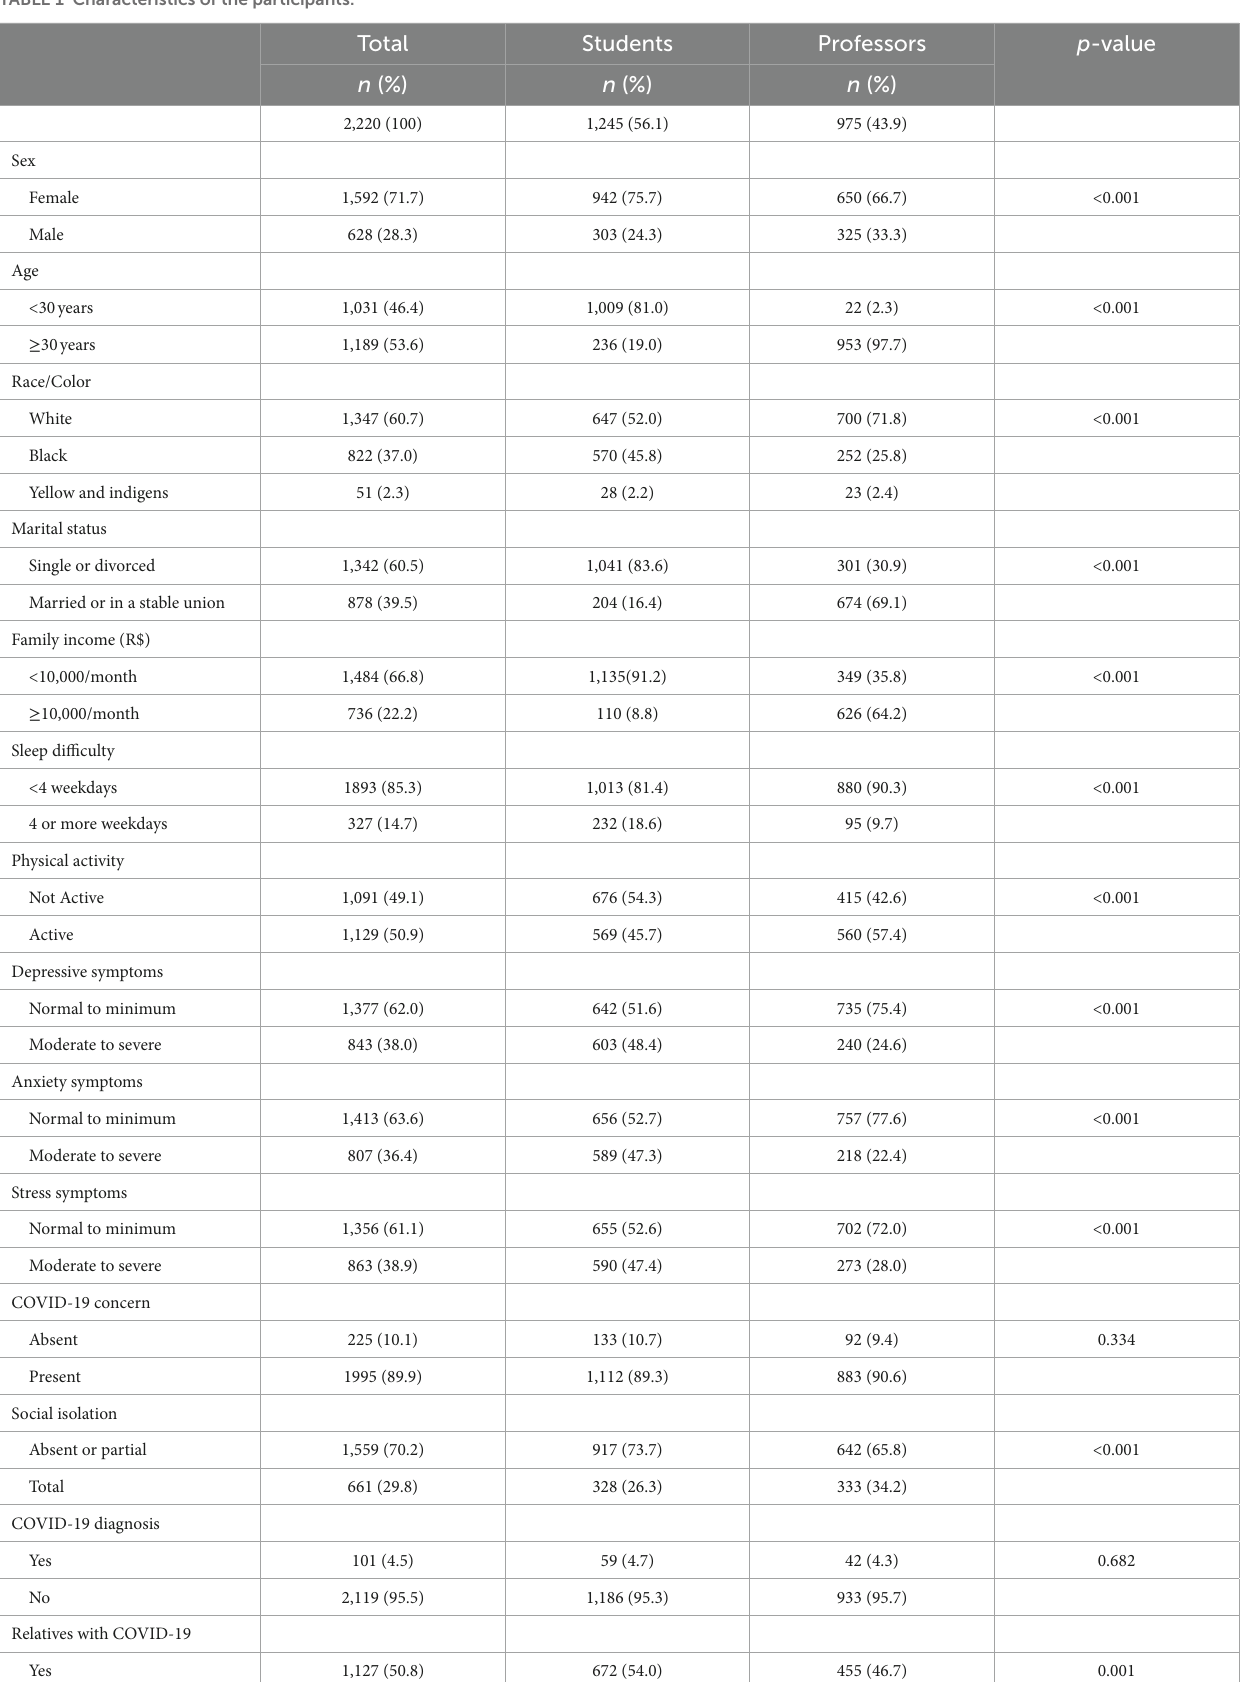
TABLE 1 Characteristics of the